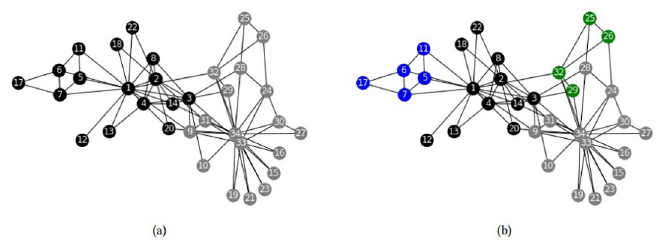
Fig 4. Zachary’s karate club disjoint community structures. Community structures obtained by (a) F ∗ parameters n c = n , p = 1, (b) F 0